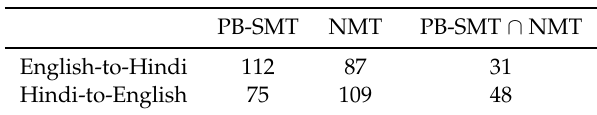
Table 9. False negatives in the PB-SMT and NMT tasks when TermEval fails to capture a correct term translation whose morphological form is different from the reference term or one of its